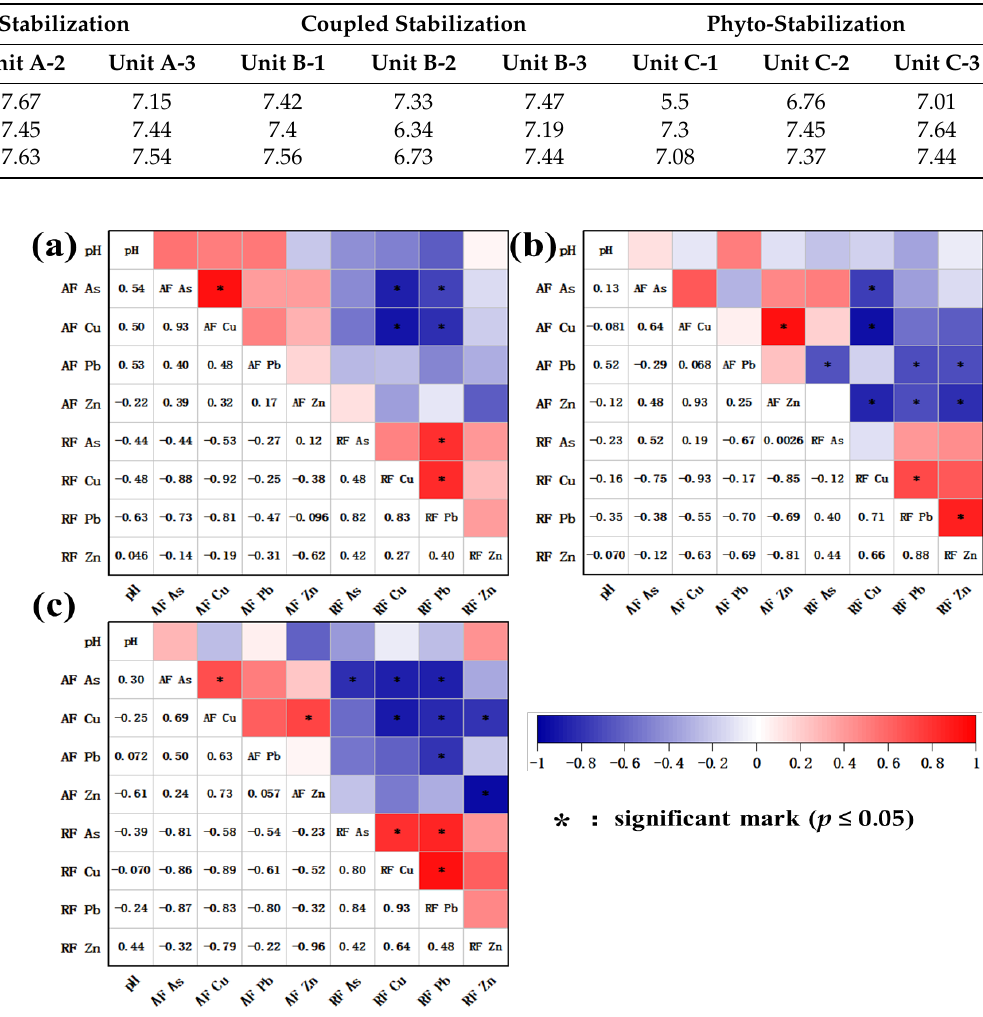
Figure 8. Correlation matrix of the pH and element fraction in the ( a ) biochar-stabilization zone, ( b ) complex stabilization zone; ( c ) phyto-stabilization zone. ( b ) complex stabilization zone; ( c ) phyto-stabilization